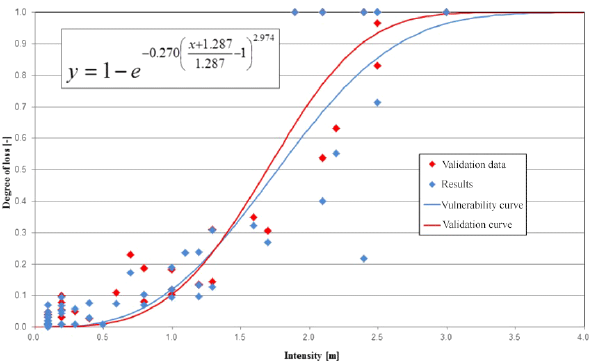
Figure 5. The vulnerability curve and the validation curve based on damage data from the 1987 debris flow event in Martell (South Tyrol) (Papathoma-Köhle et al.,